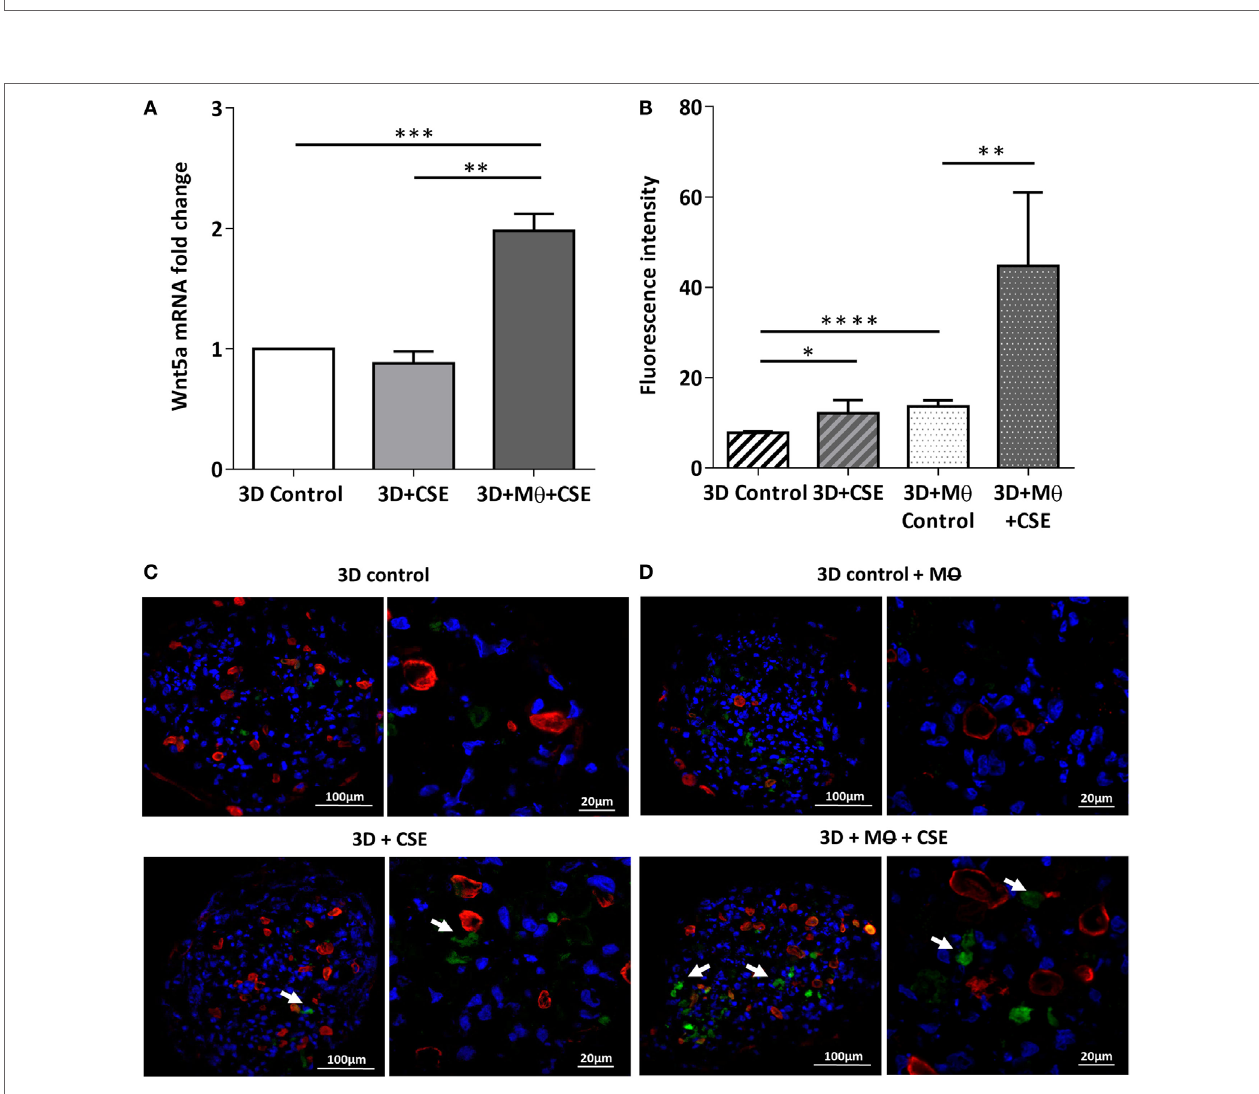
FigUre 1 | Effects of cigarette smoke (CS) on C57BL/6 mouse lungs. (a) Hematoxylin-eosin staining of paraffin embedded sections of healthy control and CS exposed lungs. Mice were exposed to CS for 1 h/day for 2 months. (Scale bars, 100 µm.) (B) Changes in EpCAM + and CD45 + cell populations in control and CS exposed lungs determined by flow cytometry. (c) Wnt5a mRNA expression changes in sorted EpCAM + and CD45 + cells following 1 and 2 months of CS exposure ( n = 3). (D) Western blot analysis of Wnt5a protein expression in control and CS exposed lung tissue extracts. (e) Detection of Wnt5a protein expression in control and CS exposed lung tissue sections [EpCAM + (green)/Wnt5a (red)/Nucleus (blue), Scale bars, 200